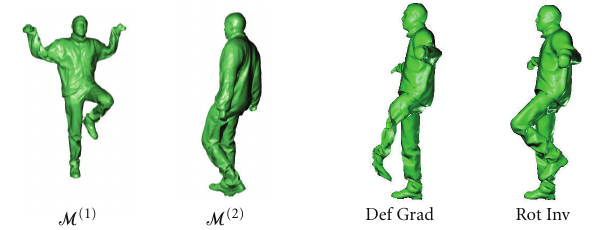
Figure 3: Handle-based surface deformation. We manipulate han- dle vertices/triangles on the surface by applying translations/rota- tions to them. The mesh deforms according to handle movements while preserving the original details. Note that, because we optimize rotations and vertices separately, rotation constraints and transla- tion constraints should be compatible with each other, otherwise, it produces distortions. Without incorporating examples, our method deforms the model smoothly regardless of anatomical structures.